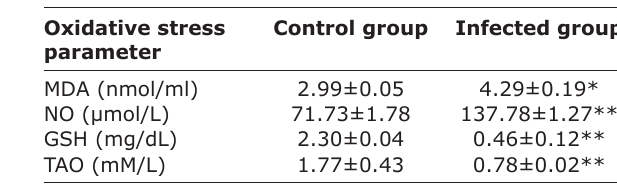
Table-3: Oxidative stress profiles for normal (Control group) and Fasciola hepatica infected cattle (Infected group).